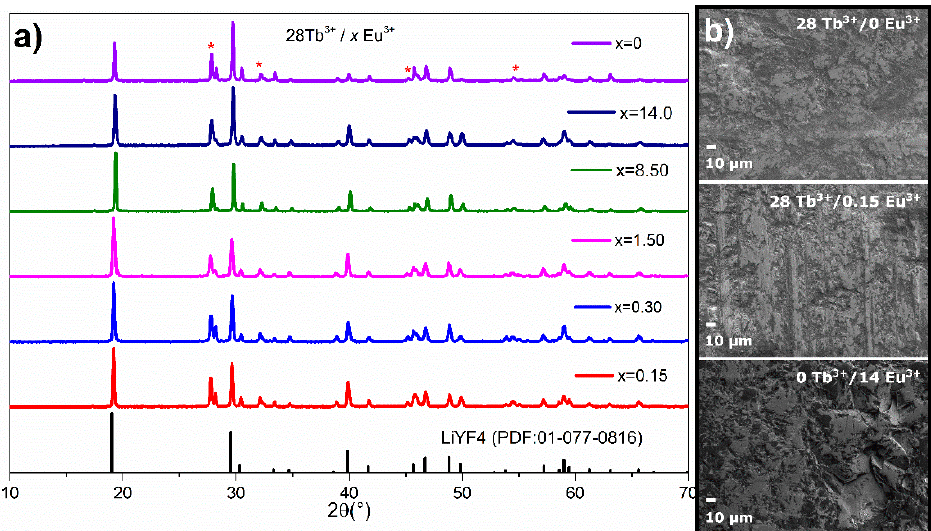
Figure 1. ( a ) X-ray diffraction pattern of the phosphor ceramic plate. The peaks marked with an asterisk correspond to the phase Y 2 Te 6 O 15 . ( b ) SEM image of the ceramic phosphor plate synthetized trough melt quenching method.